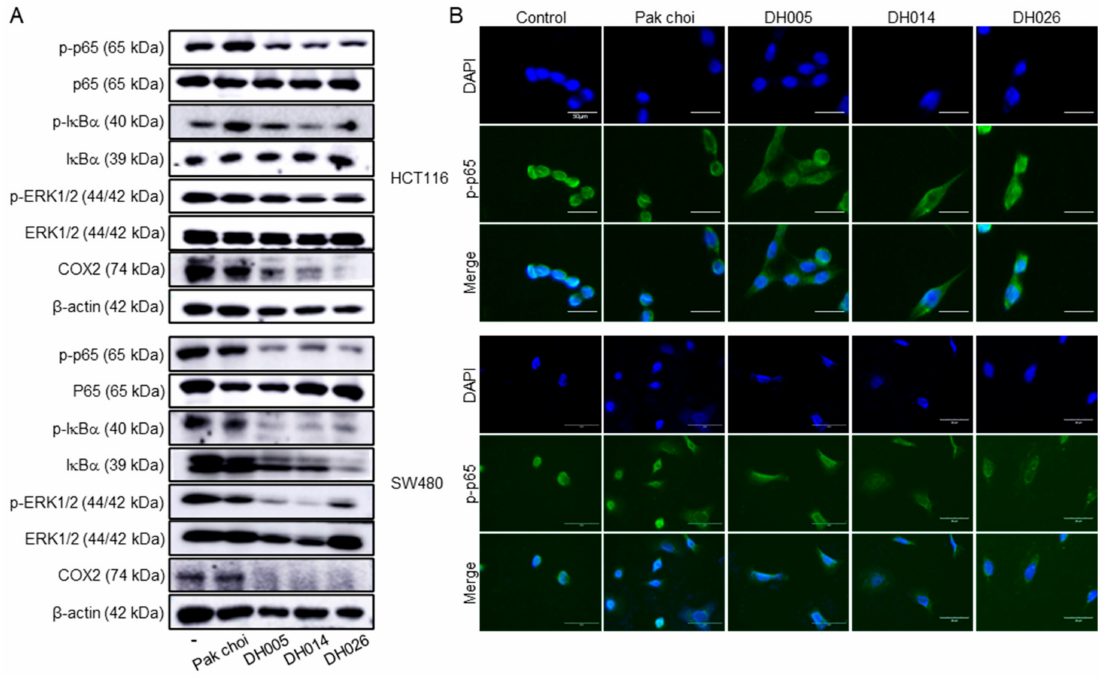
Figure 6. Effects of high glucosinolate (GSL) (HGSL) doubled haploid (DH) lines (DHLs) (DH005, DH014, and DH026) on the NF- κ B pathway in human colorectal cancer (CRC) cells. HCT116 and SW480 cells were treated with 2.5 mg/mL of each HGSL DH or pak choi (PC) extract for 24 h. ( A ) Whole-cell lysates were prepared and subjected to Western blotting for phospho (p)-p44/42 MAPK (ERK1/2) (Thr202/Tyr204) (p-ERK1/2), ERK1/2, p-I κ B α (Ser32/36) (p-I κ B α ), I κ B α , p-p65 (Ser536) (p-p65), p65, and COX2. β -actin was used as an internal control. ( B ) The treated cells were subjected to double immunofluorescence staining against p-p65 and 4 (cid:48) ,6-diamidino-2-phenylindole (DAPI) staining and analyzed by confocal microscopy (scale bar, 50 µ